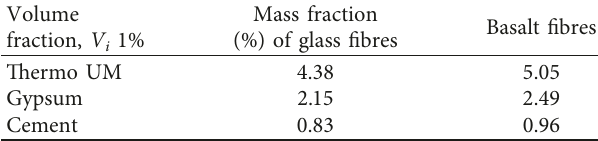
Table 3: Volume fraction of the individual components.